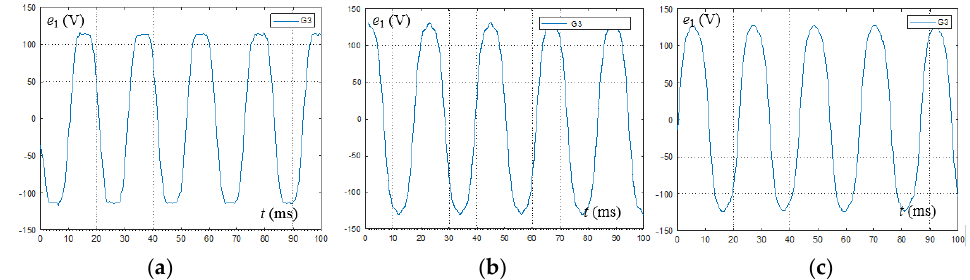
Figure 22. Waveform of induced EMF (phase 1) for the basic model with cores G3: ( a ) numerical calculations FEM; ( b ) analytical calculations; ( c ) laboratory measurements.